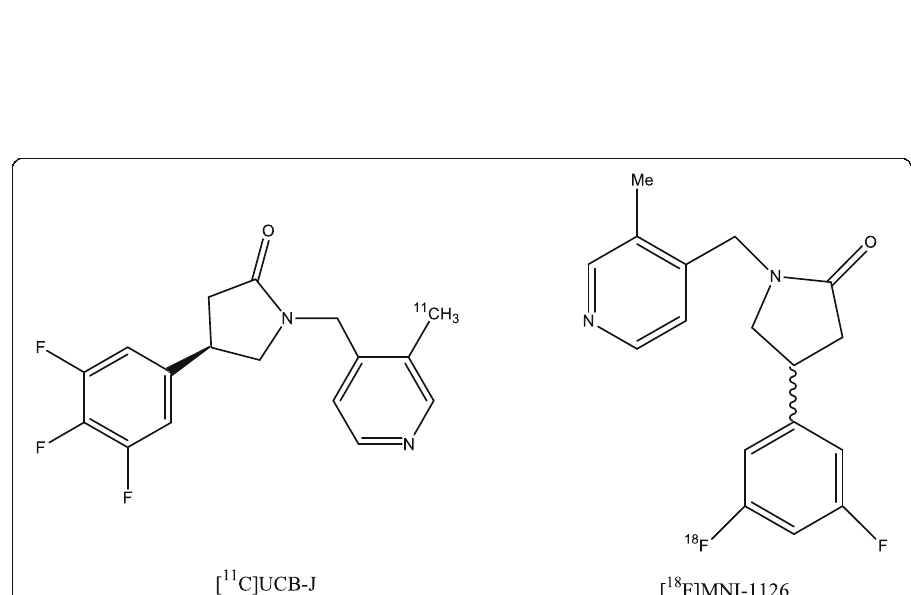
Fig. 2 Chemical structure of ((R)-1-((3-([ 11 C]-methyl-[ 11 C])pyridin-4-yl)methyl)-4-(3,4,5-trifluorophenyl)pyrrolidin-2- one) ([ 11 C]UCB-J) and its F18-labeled radioligand derivative (R)- [ 18